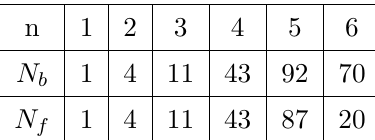
Table 2 . The number of bosonic N b or fermionic N f gauge invariant tensors constructed using n (cid:12)elds. Here N 1 = N 2 = N 3 =